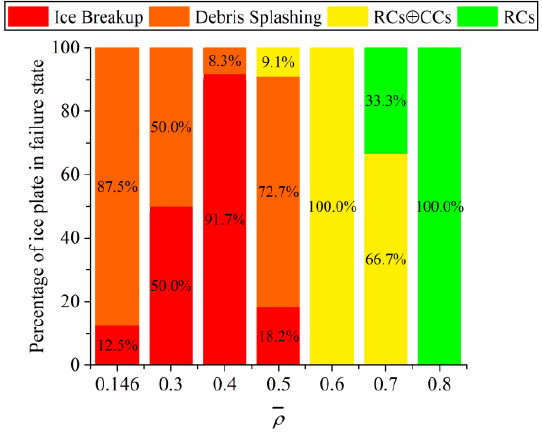
Figure 17. Probability of failure mode of ice plate impacted by spheres with different densities.